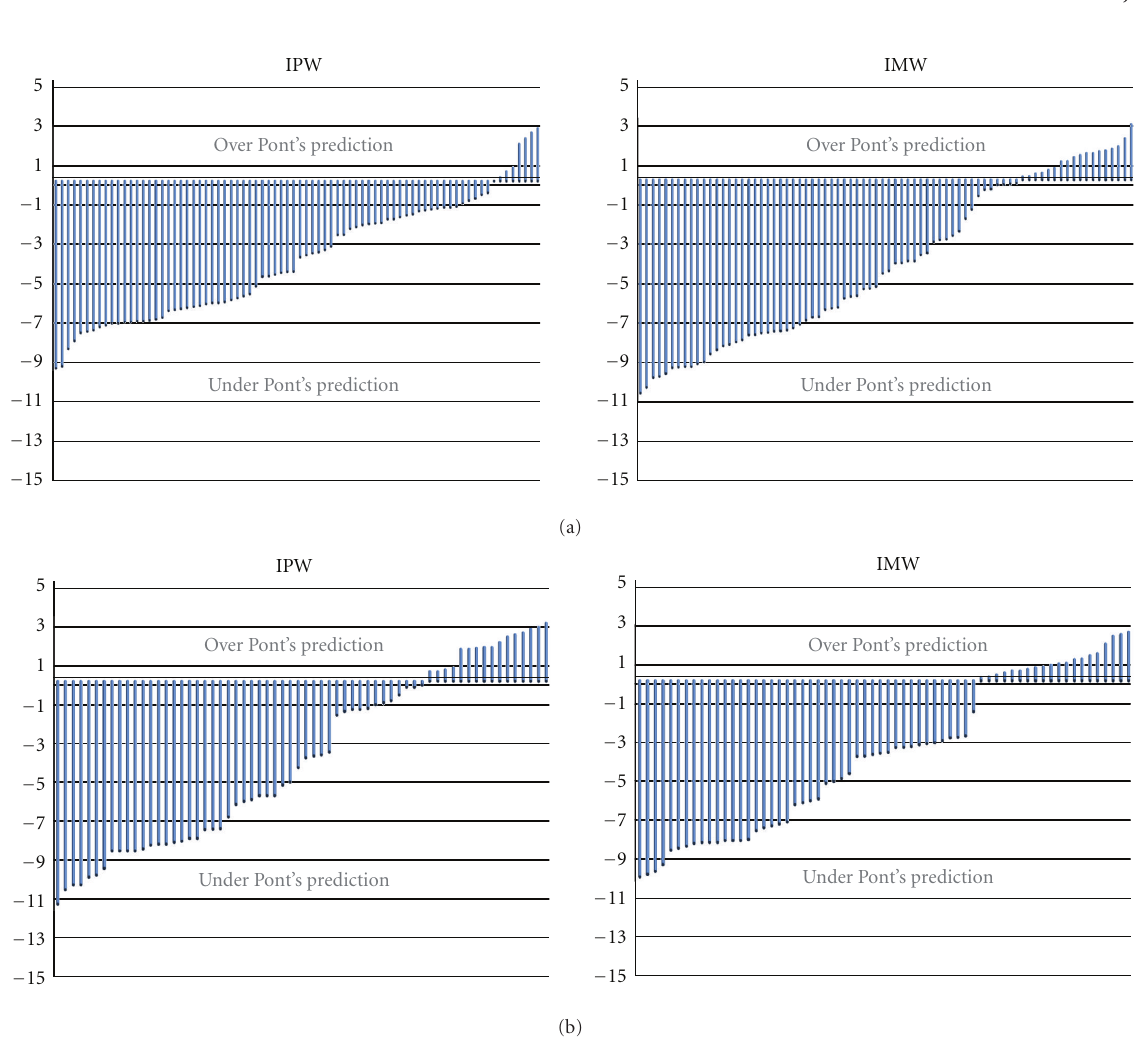
Figure 1: (a) Di ff erences between measured and predicted arch width values for females in millimetres. (b) Di ff erences between measured and predicted arch width values for males in